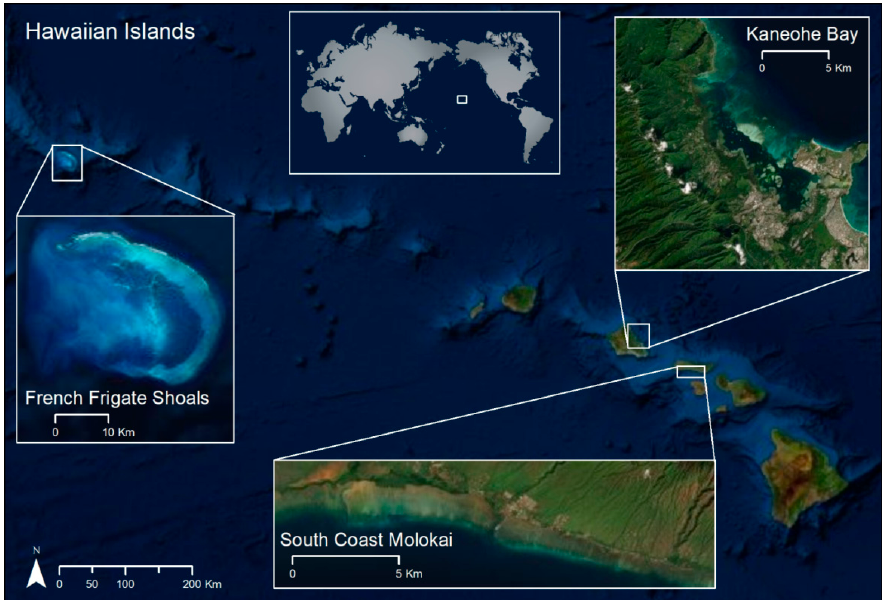
Figure 1. Location of project study areas in the Hawaiian Islands: Kaneohe Bay, Molokai, and French Frigate Shoals. Image sources: Esri, DigitalGlobe, GeoEye, Earthstar Geographics, CNES / Airbus DS, USDA, USGS, AeroGRID, IGN, and the GIS user community.